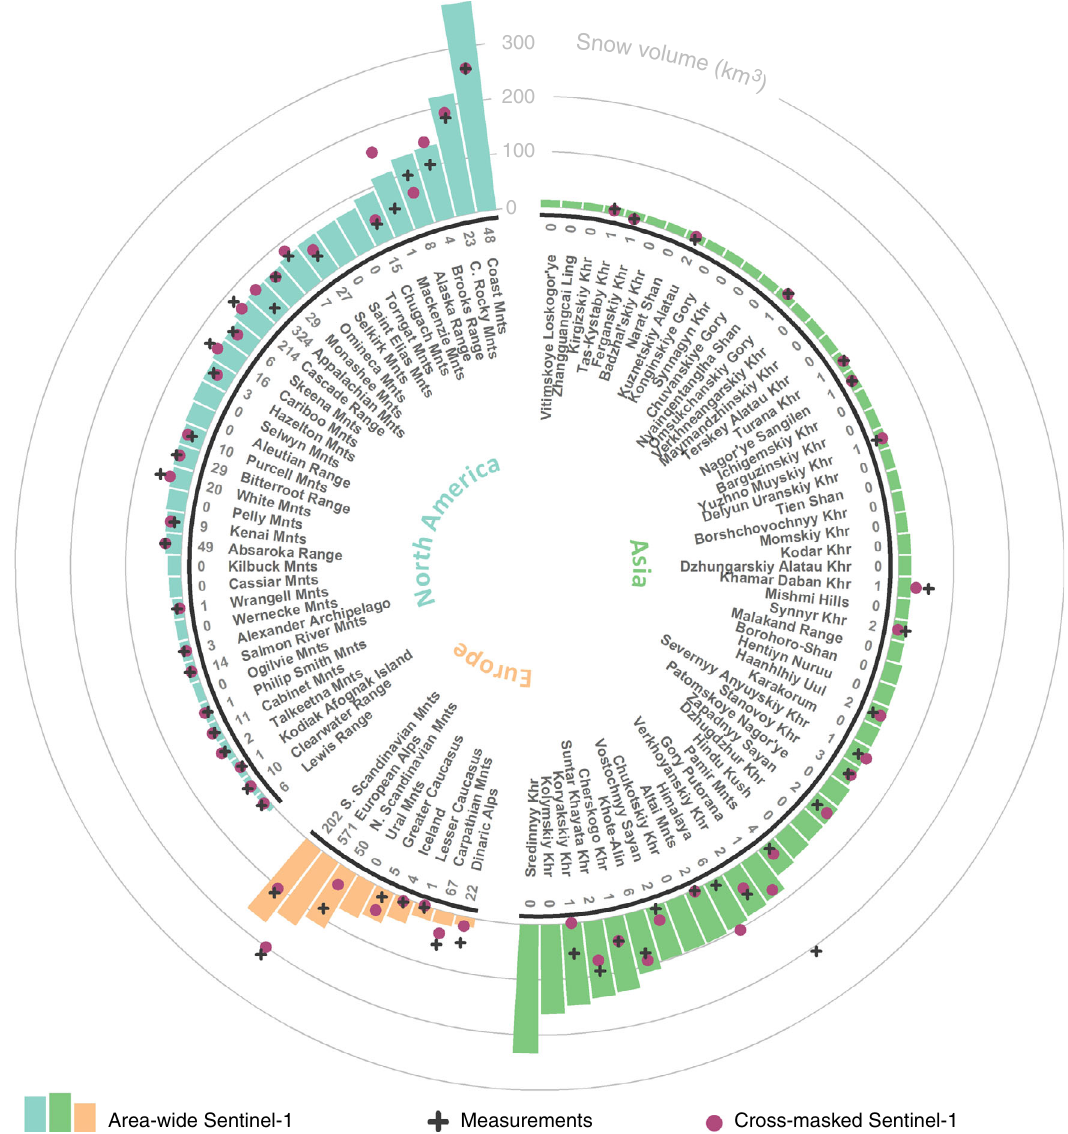
Fig. 8 Snow volumes for the top 100 snowiest mountain ranges. The snow volumes (km³) are averaged estimates over February 2018 and exclude glaciated areas. Bars represent the area-wide Sentinel-1 estimates averaged over the entire mountain range, black crosses the average of in situ measurements, and purple dots the corresponding average of cross-masked Sentinel-1 estimates, averaged only over grid cells that include in situ measurement sites. The number of in situ measurement sites, if any, is indicated next to the mountain range name. Source data are provided as a